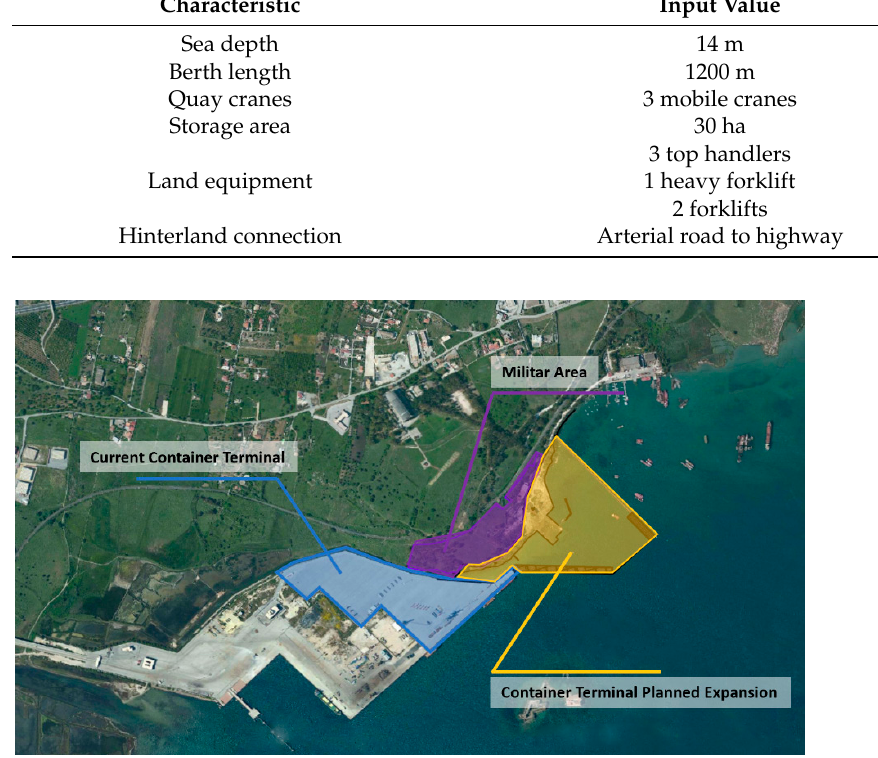
Figure 4. Current layout of terminal container and planned expansion (own elaboration) .